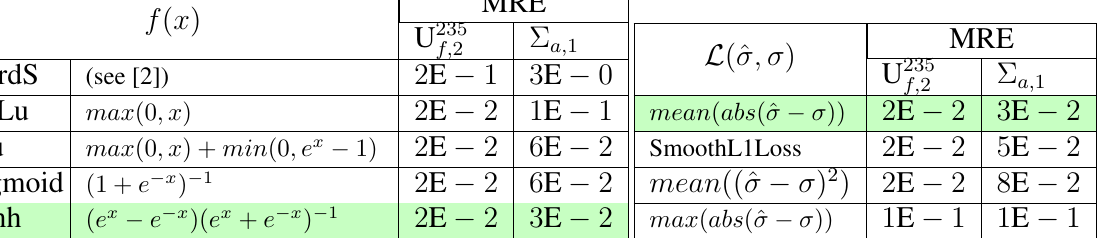
Table 3: Activation functions. Table 4: Loss